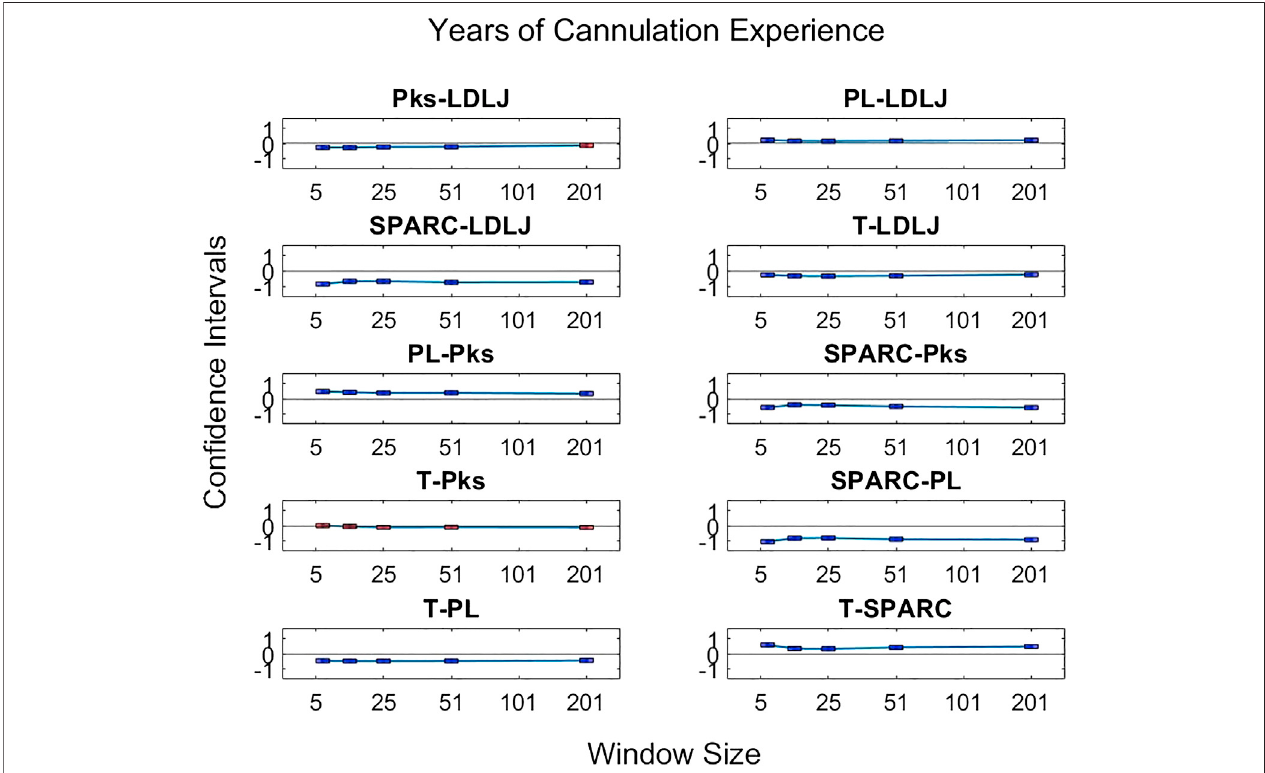
FIGURE 13 | Con fi dence intervals of signi fi cant differences of pairwise comparisons of process metrics with respect to Exp plotted against all tested window spans.Alineisdrawnthroughtheinterceptstobettervisualizethetrendofthecon fi denceintervalsofeachwindowspanincrease.Ifthecon fi denceintervalisabovezero, the minuend is more strongly associated with Exp ; if it passes through zero, the differences are insigni fi cant; and if it is below zero, the subtrahend is more strongly associated with Exp .